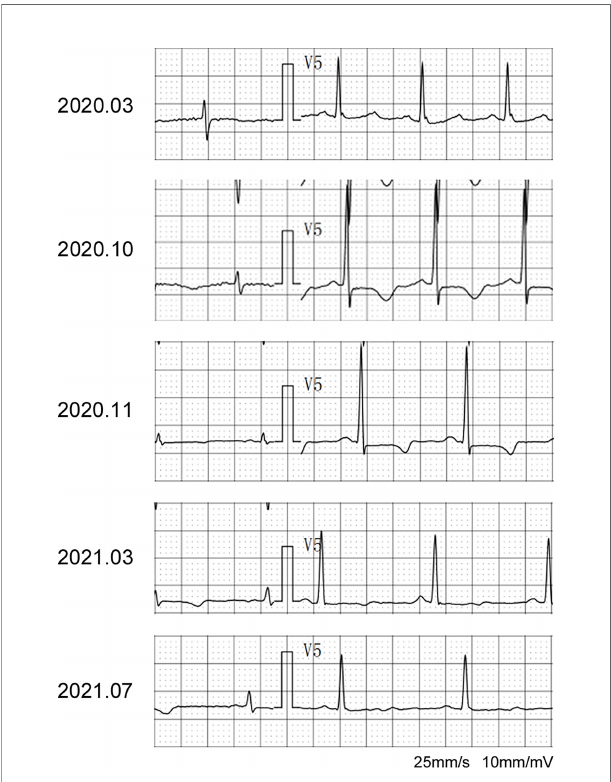
FIGURE 5 | The changes in RV5 of electrocardiogram at cardiac failure and during recovery treatment.